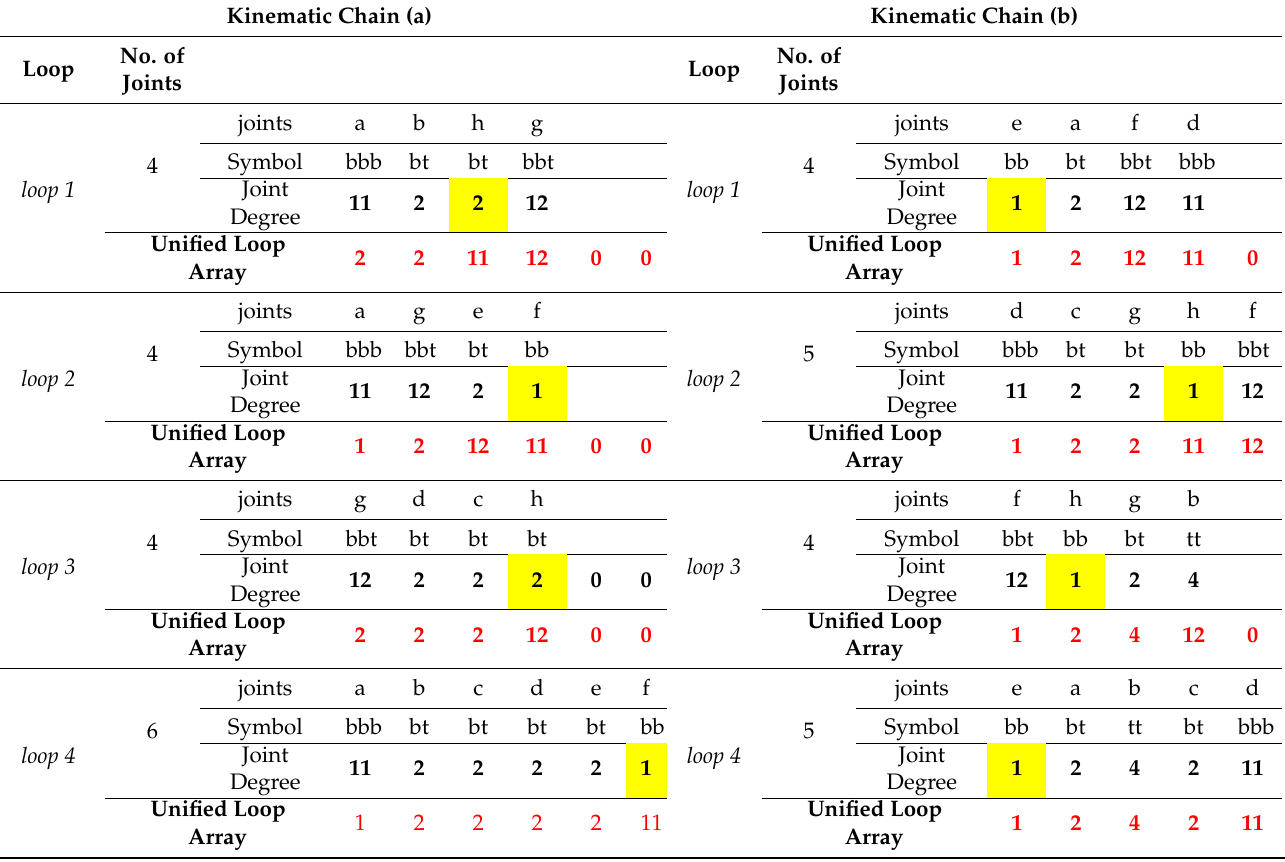
Table 7. Unified Joint Degree Array for KCs in Figure 11a,b.